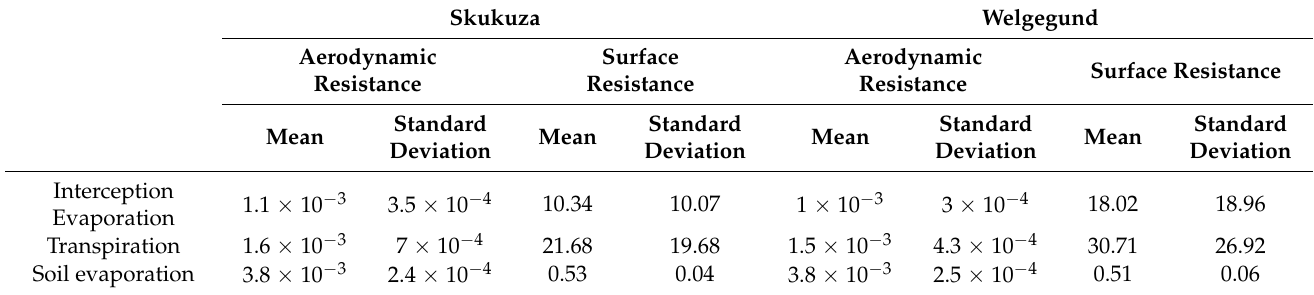
Table 5. Aerodynamic and surface resistance standard uncertainties and contributions to each component of ET uncertainty.